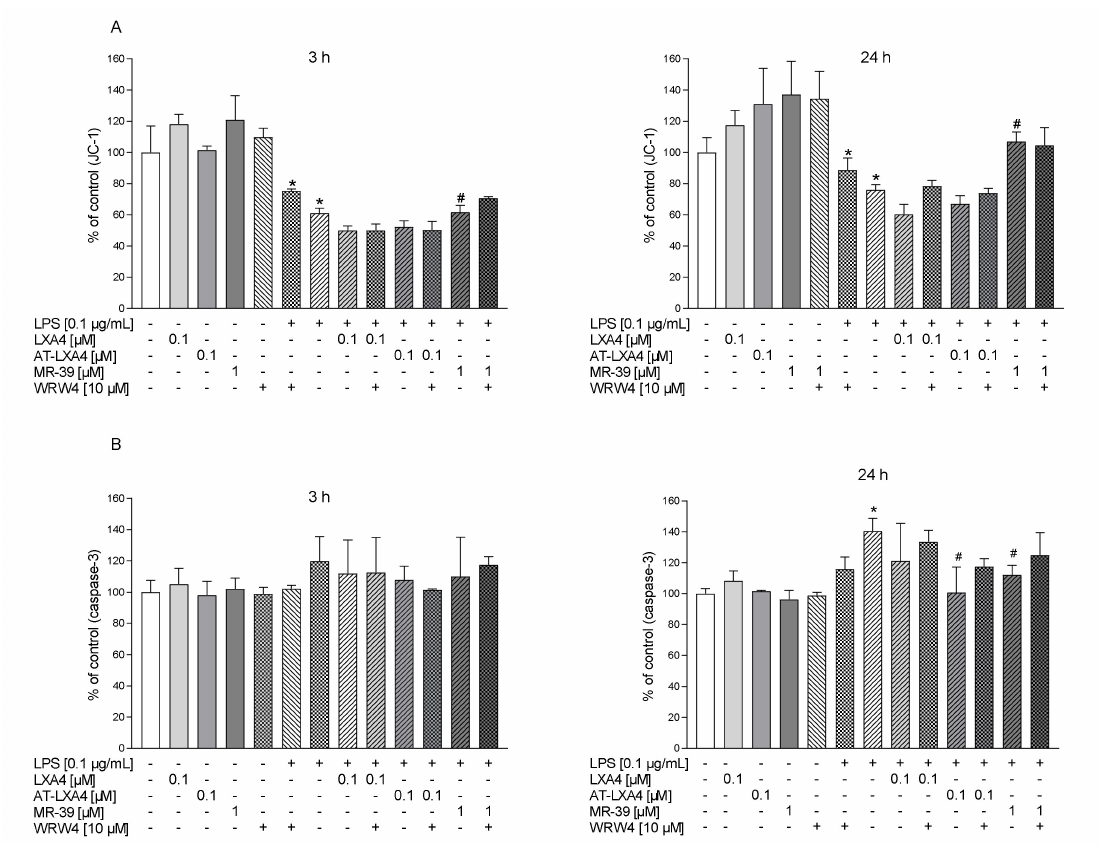
Figure 6. The impact of LXA4, AT-LXA4, and MR-39 on the mitochondrial membrane potential ( A ) and caspase-3 activity ( B ) in rat microglial cultures. The cells were pretreated for 30 min with the FPR2 antagonist WRW4 (10 µ M). After that, LXA4 (0.1 µ M), AT-LXA4 (0.1 µ M), or MR-39 (1 µ M) was added for 1 h, and then the cells were stimulated for 3 h or 24 h with lipopolysaccharide (LPS; 0.1 µ g/mL). Control cultures were treated with the appropriate vehicle. The data are presented as the mean ± SEM percentage of control (vehicle-treated cells) of independent experiments, n = 2–5 in each experiment. * p < 0.05 vs. control group, # p < 0.05 vs. LPS group. LXA4: lipoxin A4; AT-LXA4: aspirin-triggered lipoxin A4; LPS: